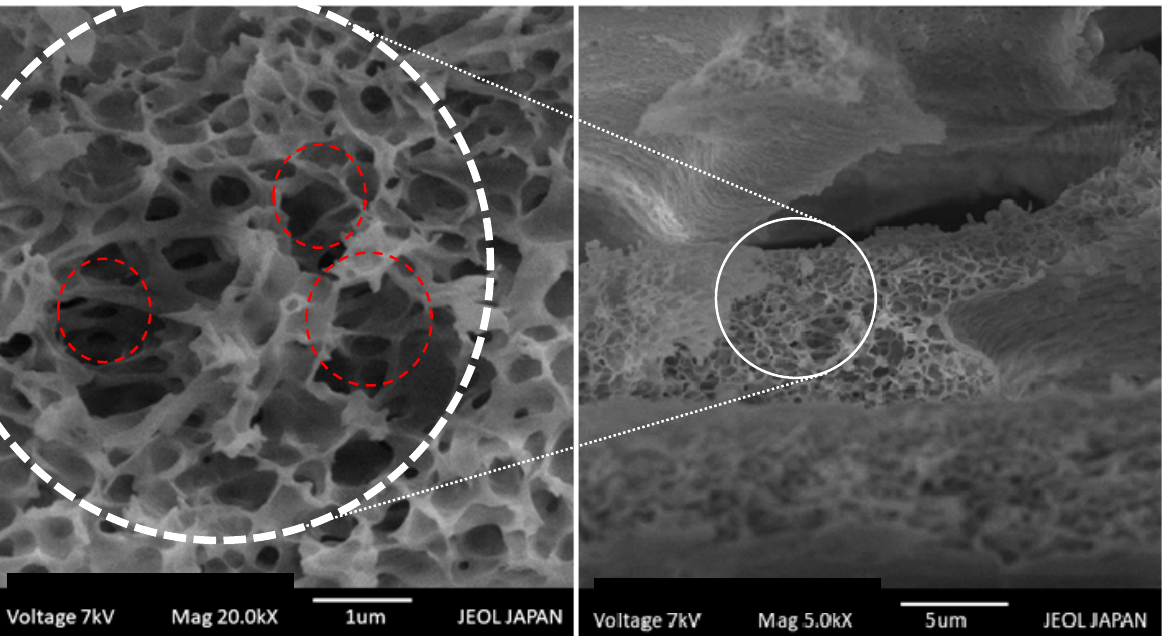
Figure 8 . SEM images of smart gel formulation (F9) depicting the Agarose–Carbopol scaffold structure.